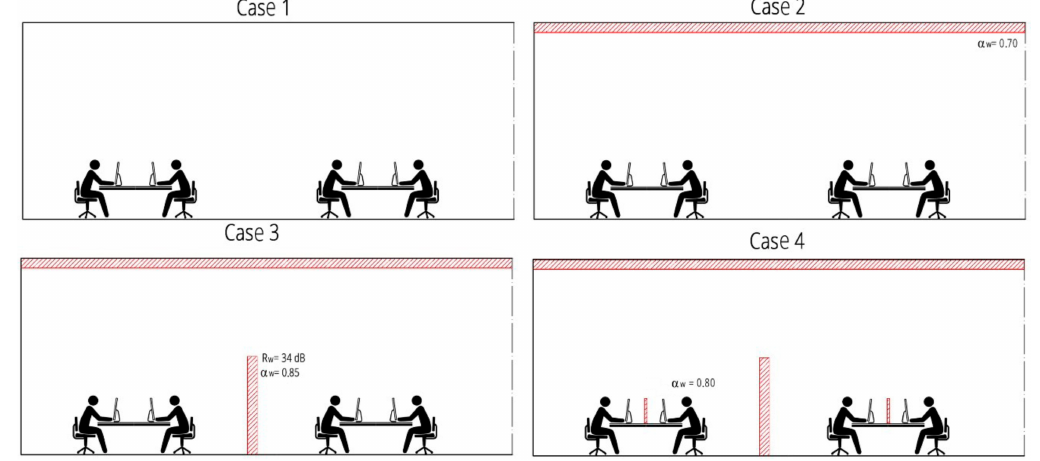
Figure 6. The examined office